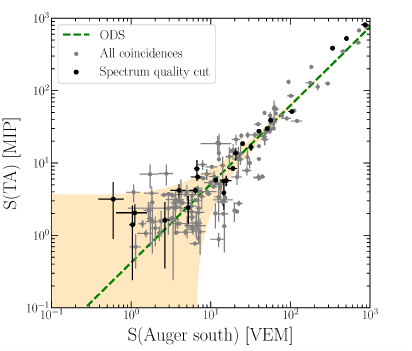
Figure 3. S(TA[MIP]) vs S(Auger[VEM]) correlation measured between the TA and Auger stations at the CLF. The black points show the 23 events that passed the TA reconstruction quality cuts. The regression fit presented is performed on all the data.